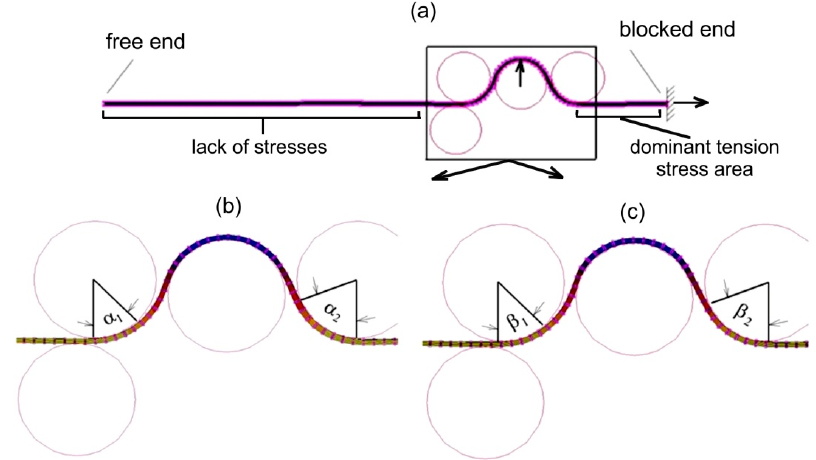
Figure 13. The character of the specimen deformation around the working rollers ( a ) for the drawbead height of h = 18 mm, and specimen width w = 20 mm for ( b ) the friction and ( c ) frictionless conditions.